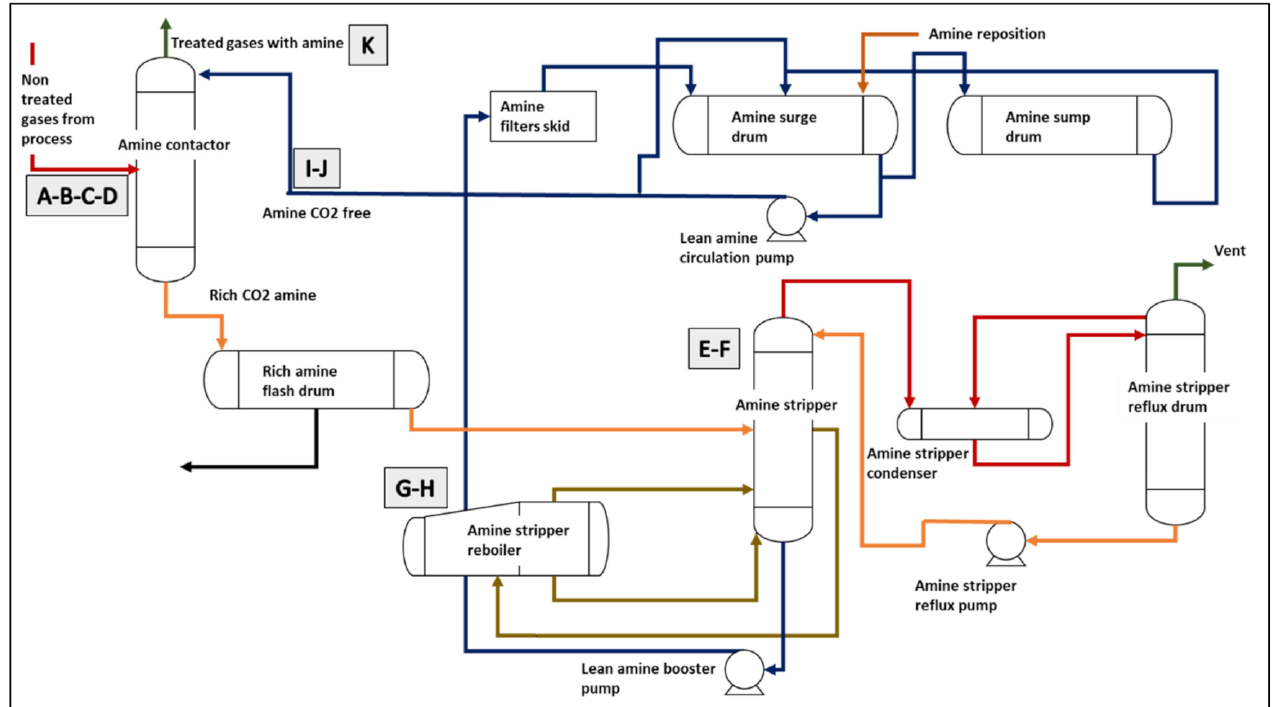
Figure 4. CO 2 removal process illustration. Source: